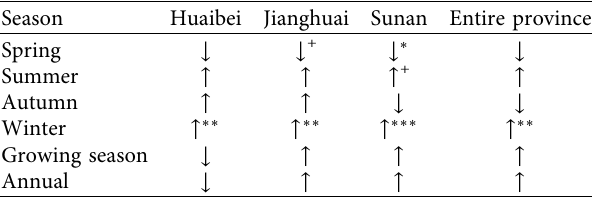
Figure 3: Spatial distribution of the sites with decreasing or increasing humidity index (HI) at seasonal and annual scales during 1961–2019 throughout Jiangsu province; the solid red inverted and blue regular triangles indicate the negative and positive trends of HI, respectively. (a) Spring, (b) summer, (c) autumn, (d) winter, (e) growing season, (f) annual. Table 2: Trends of seasonal and annual humidity index (HI) in Huaibei, Jianghuai, Sunan, and the entire province during 1960–2019 using the Mann–Kendall test.